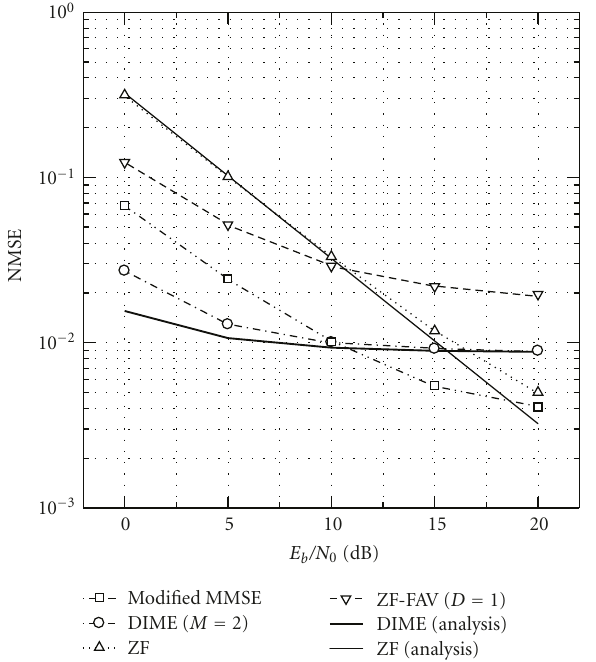
Figure 4: NMSE performance with σ/T = 0 . 043 and f d T = 0 . 0075.